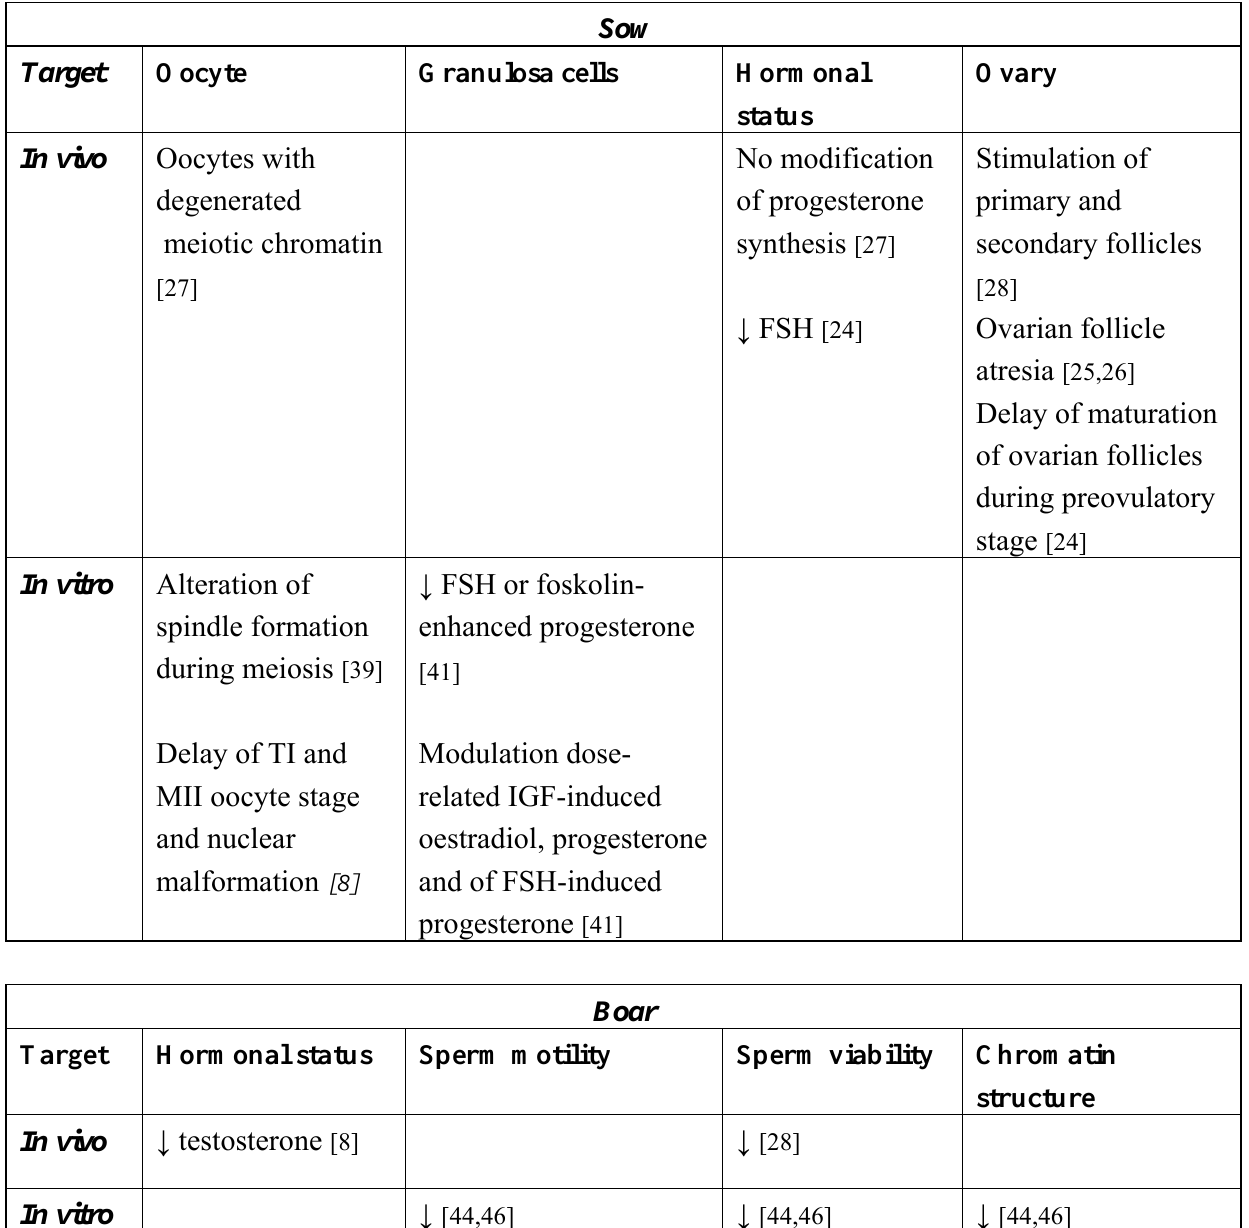
Table 1 . Comparative in vivo and in vitro toxic effects of zearalenone and its derivative in